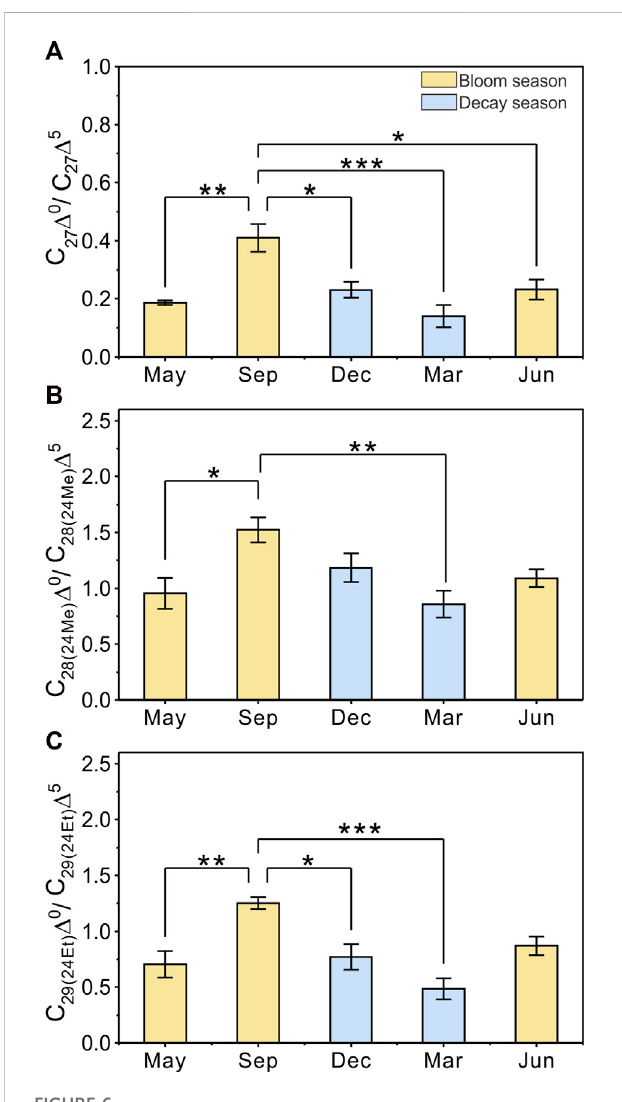
FIGURE 6 Seasonality of anaerobic bacteria activities in sediments indicated by the C 27 Δ 0 /C 27 Δ 5 ratios (A) , C 28(24Me) Δ 0 /C 28(24Me) Δ 5 ratios (B) , and C 29(24Et) Δ 0 /C 29(24Et) Δ 5 ratios (C) . The yellow bar represents the cyanobacterial bloom season, the blue bar represents the cyanobacterial decay season. Histograms show average values and 1.5 SE. The level of signi fi cance from the one-way analysis is reported as * p < 0.05, ** p < 0.01, *** p <